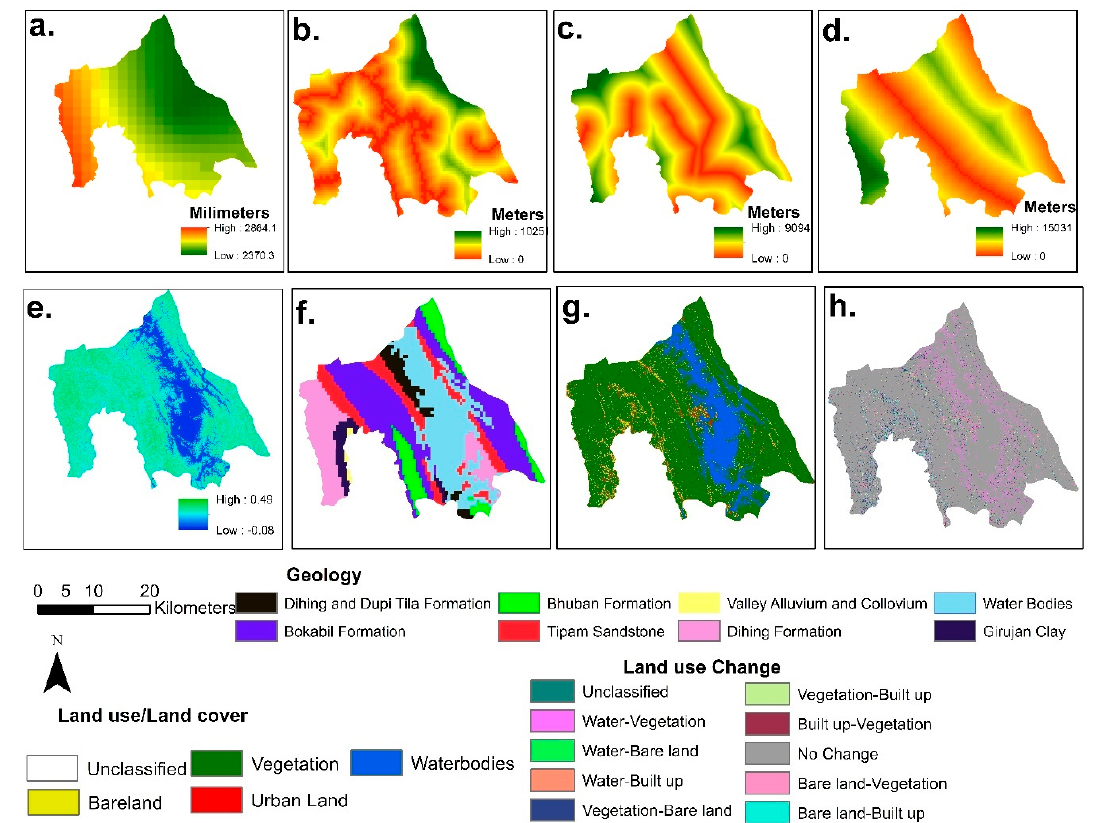
Figure A3. Landslide Causal Factors: ( a ) Rainfall; ( b ) Distance from the Road Networks; ( c ) Distance from the Drainage Networks; ( d ) Distance from the Fault Lines; ( e ) NDVI; ( f ) Geology; ( g ) Land Use / Land Cover; ( h ) Land Use / Land Cover Change.